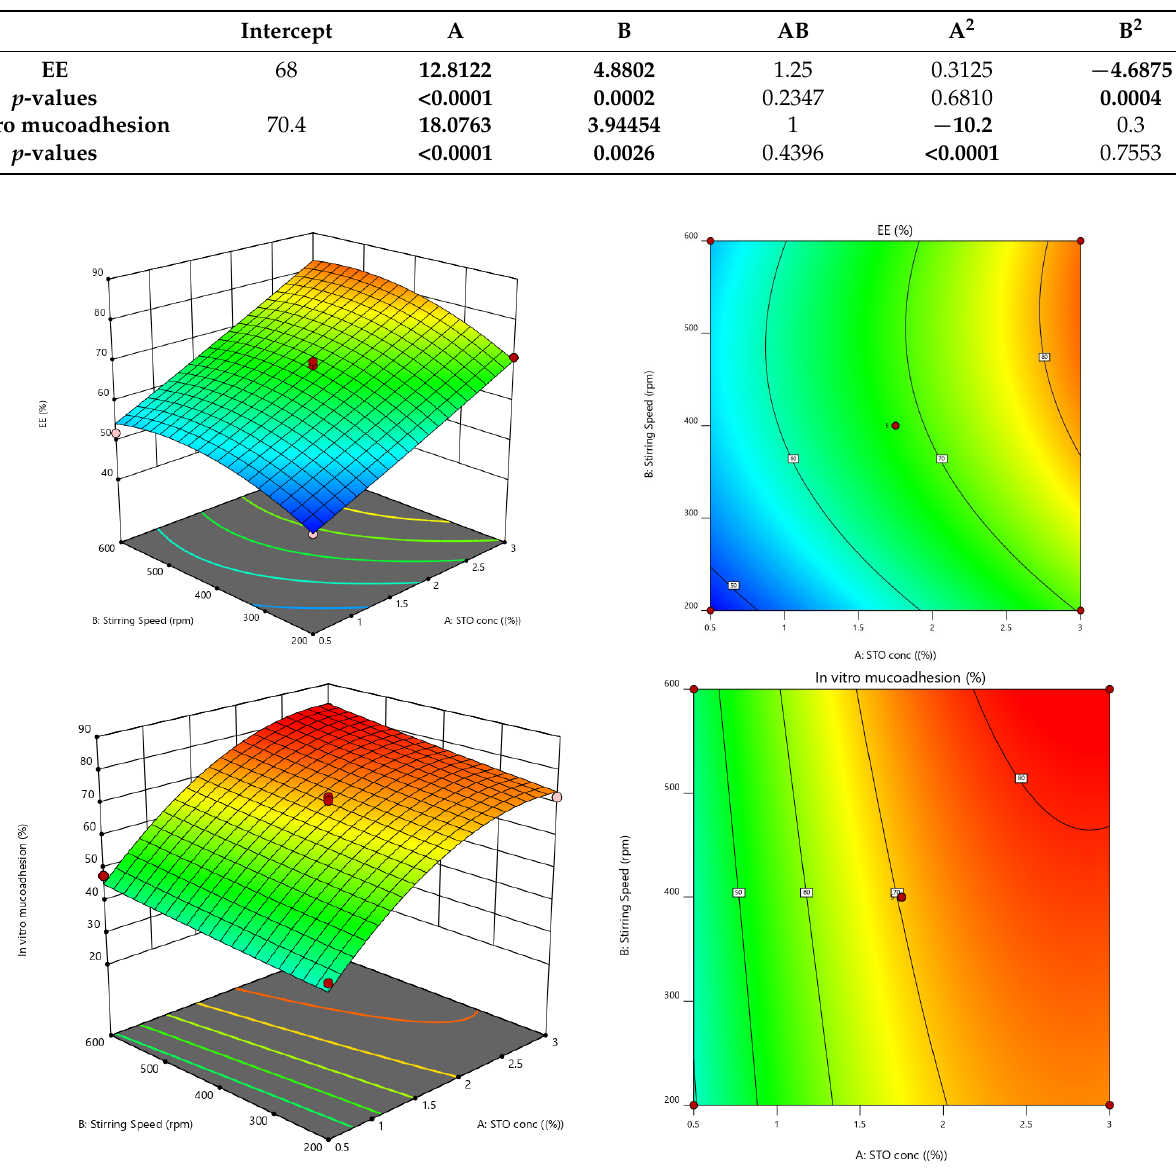
( b ) Figure 4. ( a ) Overlay plot and ( b ) desirability bar graph for an optimized result. 2.3. Characterization and Evaluation of G-STO-M G-STO-M was formulated using optimized conditions and evaluated for EE, and in vitro mucoadhesion and the results were found to be 82.54 and 83.64%, respectively. High STO concentration contributed to maximizing the EE, as the polymer got precipitated on the dispersed phase; this would not permit the drug to cross the surface border and raise the viscosity, which further reduces the diffusion of the drug inside the polymer droplets. Concerning stirring rate, an increase in stirring speed dissects the emulsion into smaller droplets, leading to the formation of smaller microspheres. These small droplets permit drug diffusion before it becomes hard and forms a microsphere, which minimizes the EE of the system. The stirring rate had a lesser effect on mucoadhesion than the concentration of STO, which may be ascribed to a smaller particle size at more incredible speeds, leading to a higher surface area. In contrast, the internal-to-external phase ratio did not have any effect. The surface morphology of G-STO-M with a presence of STO was noted to be dis- crete, globular, free-flowing, having a rough surface (Figure 5). The rough surfaces may result from microsphere accumulation and quick gelation of a thiomer.